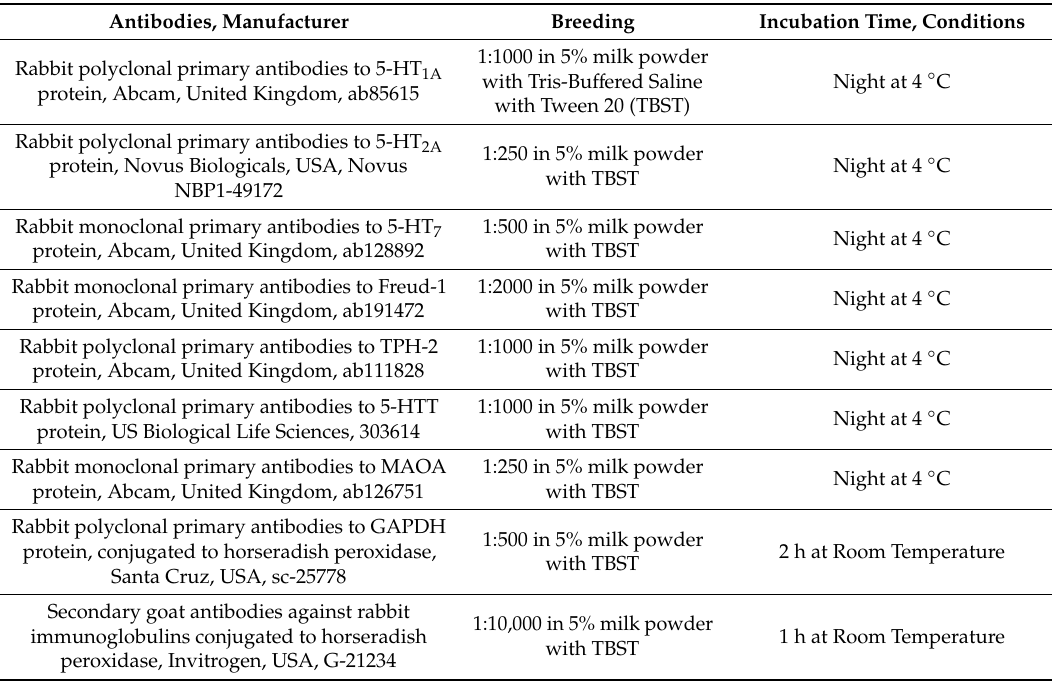
Table 3. List of antibodies used and immunodetection